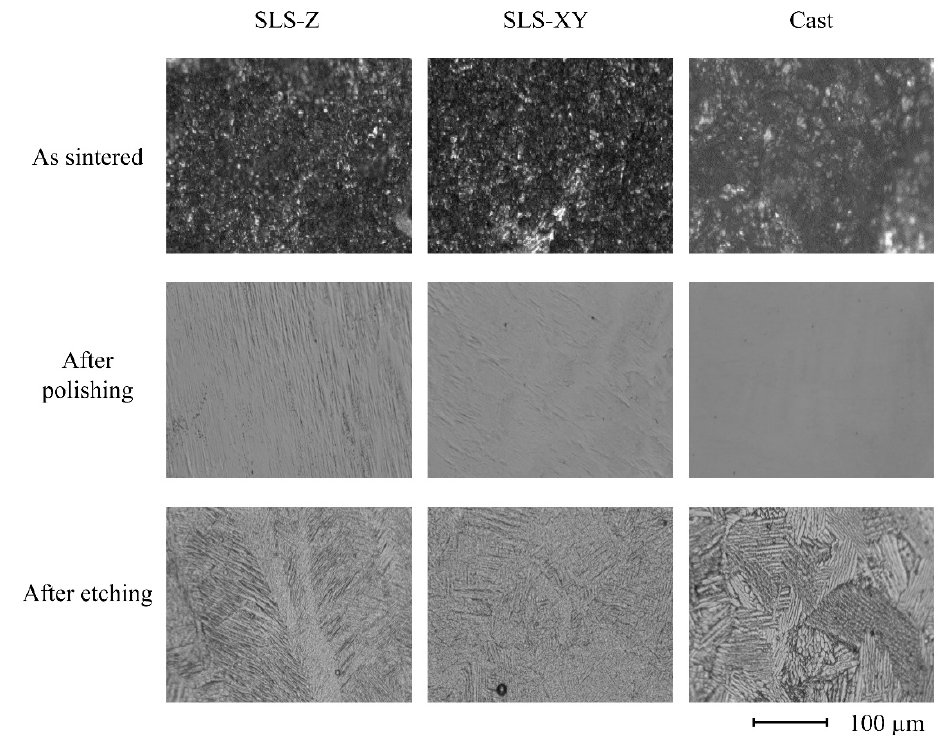
Figure 9. Digital microscope images of SLS-Z, SLS-XY, and cast Ti-6Al-4V specimens as sintered, after polishing, and after etching (×1000).